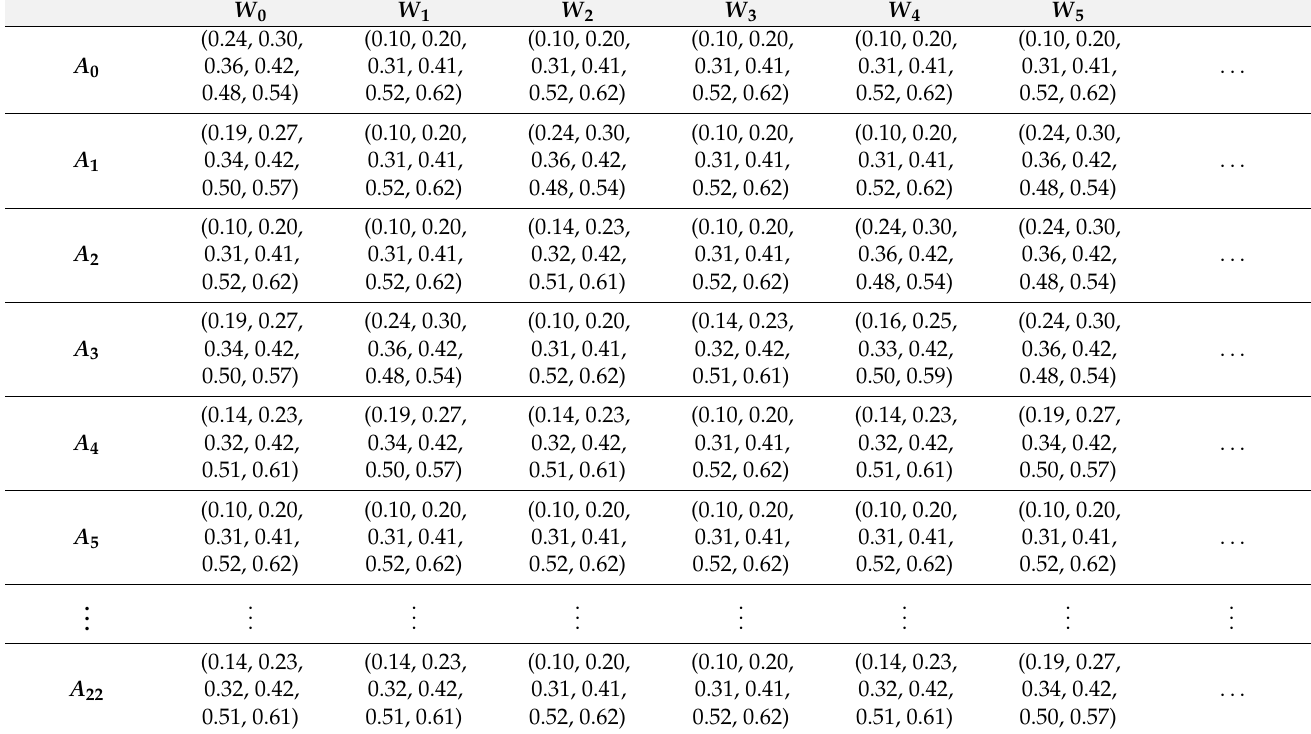
Table 9. The normalized decision matrix.